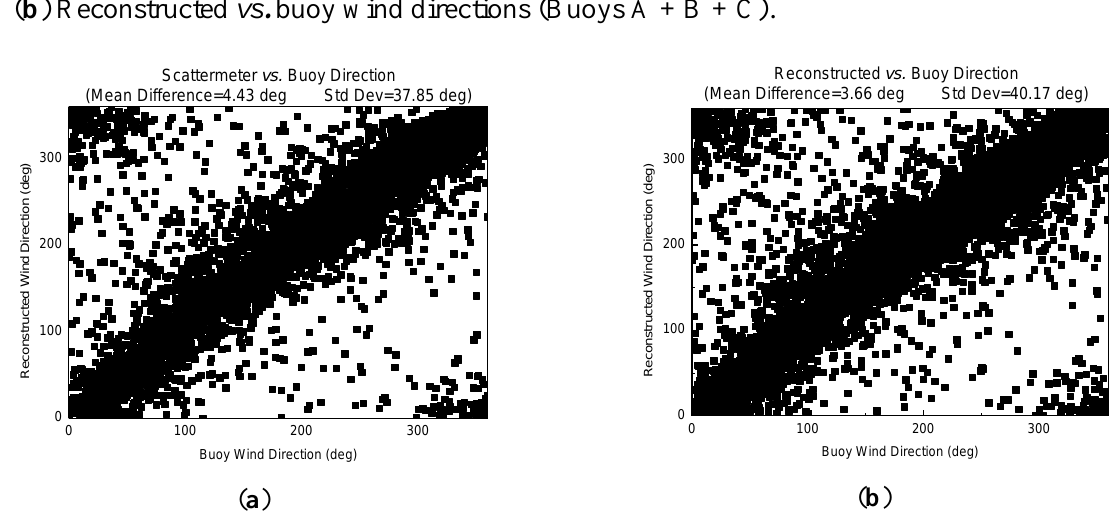
Figure 2. ( a ) Blended products (BP) vs. buoy wind directions (Buoys A + B + C). ( b ) Reconstructed vs. buoy wind directions (Buoys A + B + C).